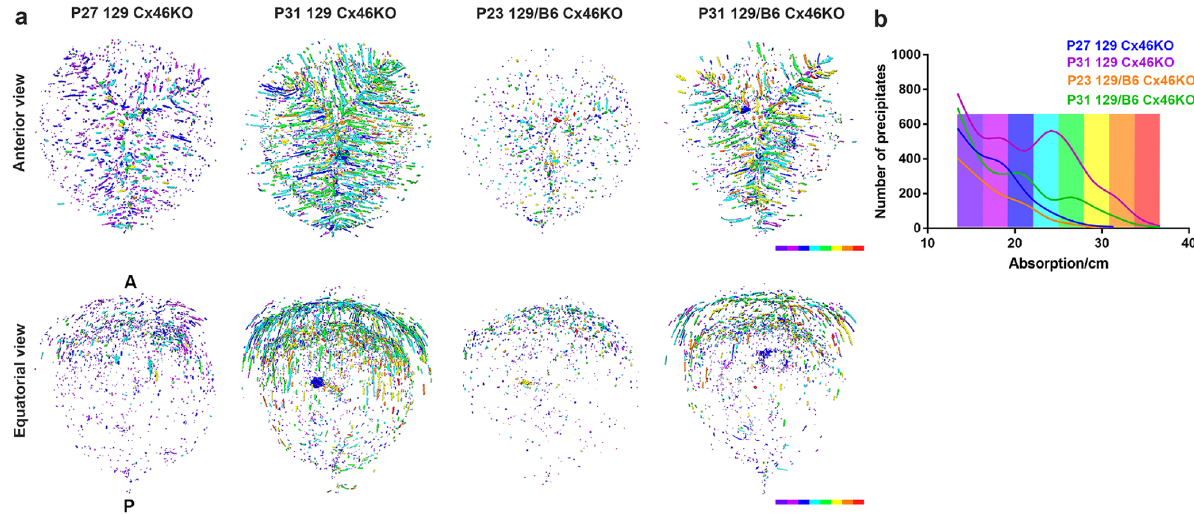
Figure 4. Absorption measurement and quantification of precipitates in Cx46KO lenses. The same individual Cx46KO lenses in Fig. 2 were analyzed. ( a ) Precipitates were measured by absorption per centimeter value in the cataract regions of 129 Cx46KO (P27 and P31) and 129/B6 Cx46KO (P23 and P31) lenses. Individual precipitates, in both anterior and equatorial views, were colored based on the color bar, red/orange for high density precipitates and purple/blue for low density precipitates. Lens anterior (A) and posterior (P) poles were indicated on the left equatorial image. ( b ) A graph shows precipitate numbers in different absorption values, the color bars are the same as in a, representing the regions of all images in ( a